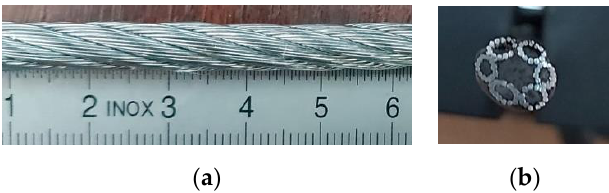
Figure 3. Wire rope subjected to dynamic experimental tests: ( a ) lateral view with rule for geometrical characterization; and ( b ) transversal sectional view.